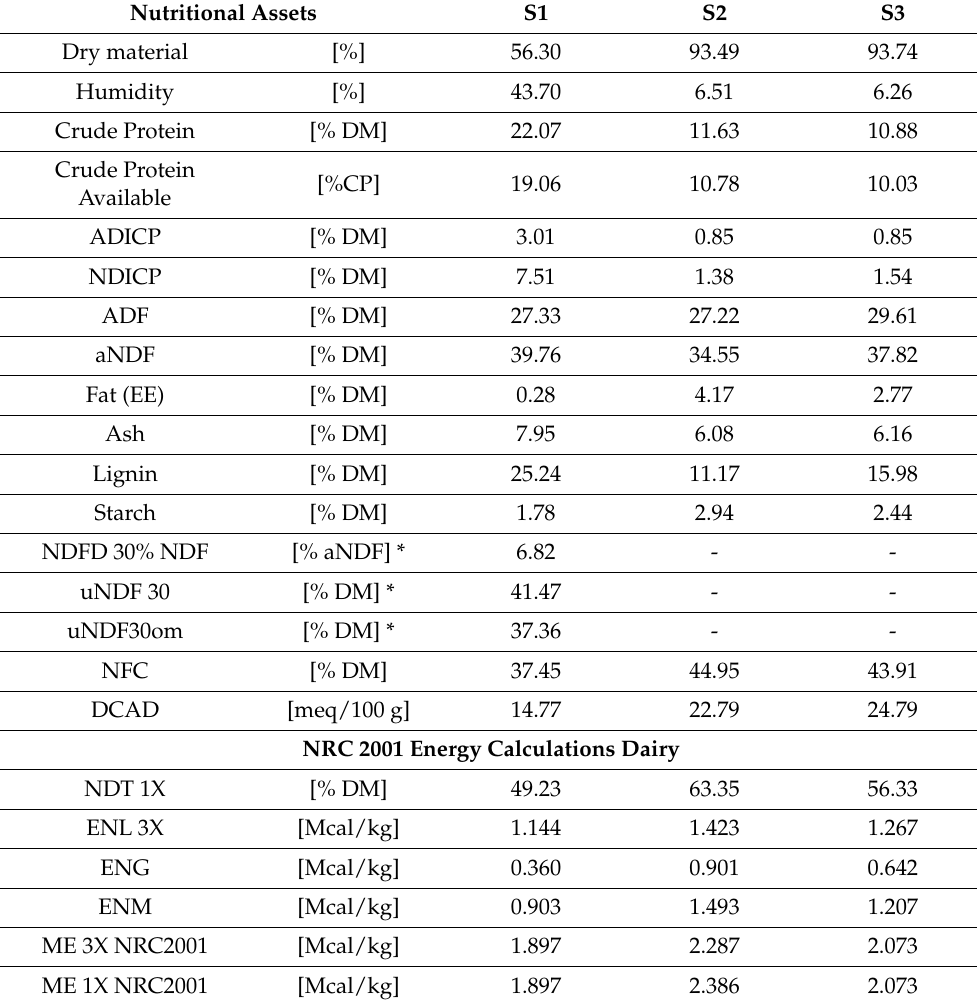
Table 2. Nutrient composition of IP submitted to different